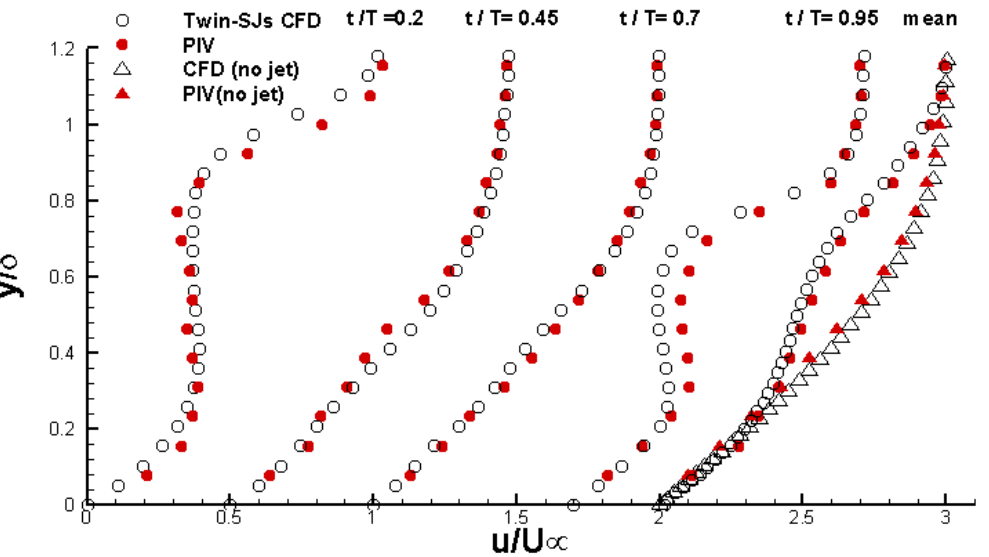
Figure 4. Comparison of instantaneous and time-averaged streamwise velocity profiles taken at x = 4 D o from the CFD and PIV data for twin SJs operating at Δ ϕ = 0. The t / T = 0.45, 0.7, 0.95 profiles and the mean profile are shifted by u / U ∞ = 0.5, 1.0, 1.7 and 2, respectively.